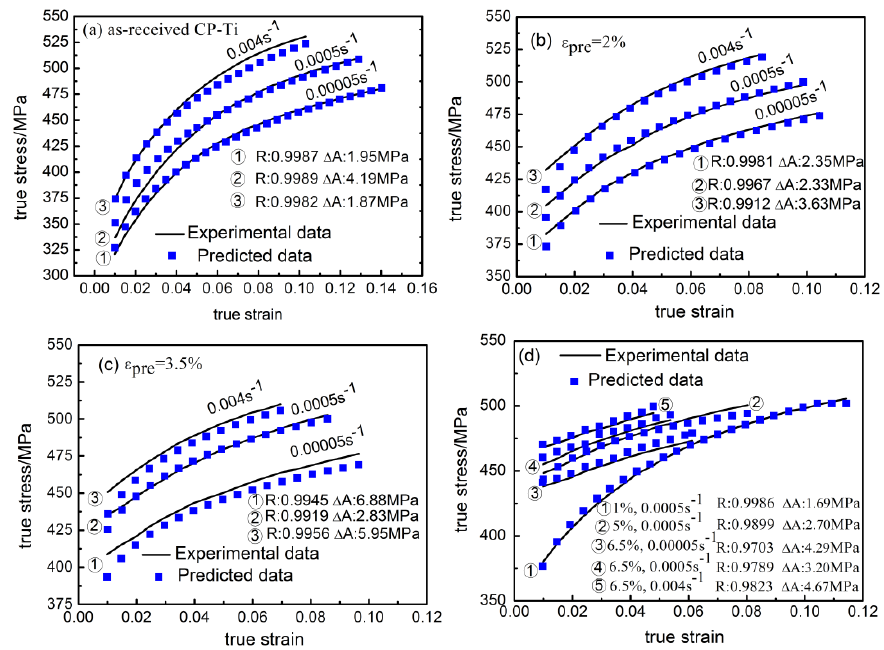
Figure 15. Comparison between the experimental and predicted flow stress data from the modified Fields-Backofen model: ( a ) as-received CP-Ti; ( b ) 2% prestrained CP-Ti; ( c ) 3.5% prestrained CP-Ti; ( d ) 1%, 5%, 6.5% prestrained CP-Ti.